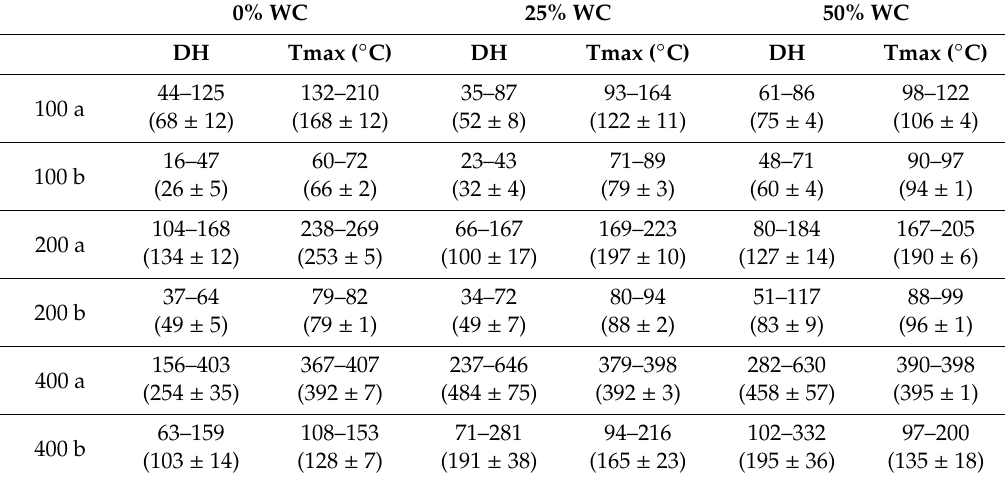
Table 1. Degree hours (DH) and maximum temperature reached (Tmax) of the soil mixtures with di ff erent water content (WC) and heated to 100 ◦ C, 200 ◦ C and 400 ◦ C. a, soil layer (0–2 cm); b, soil layer (2–4 cm). Range of values and average of the three di ff erent soil mixtures ±